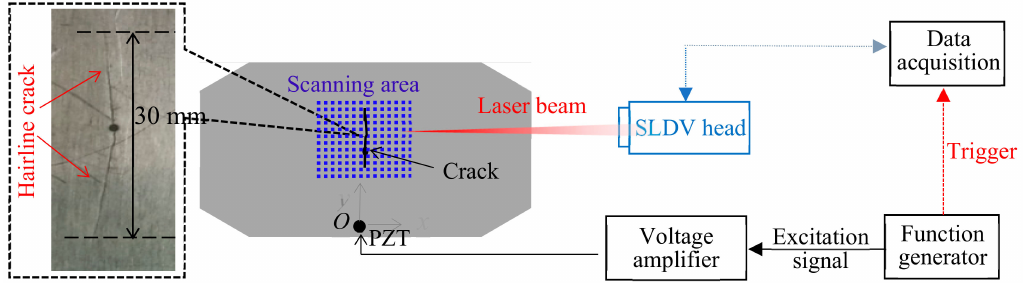
Figure 2. The schematic setup of the lead zirconate titanate (PZT) Lamb wave inspection system for crack detection combined with SLDV to obtain the multi-dimensional scattered waves as well as the incident